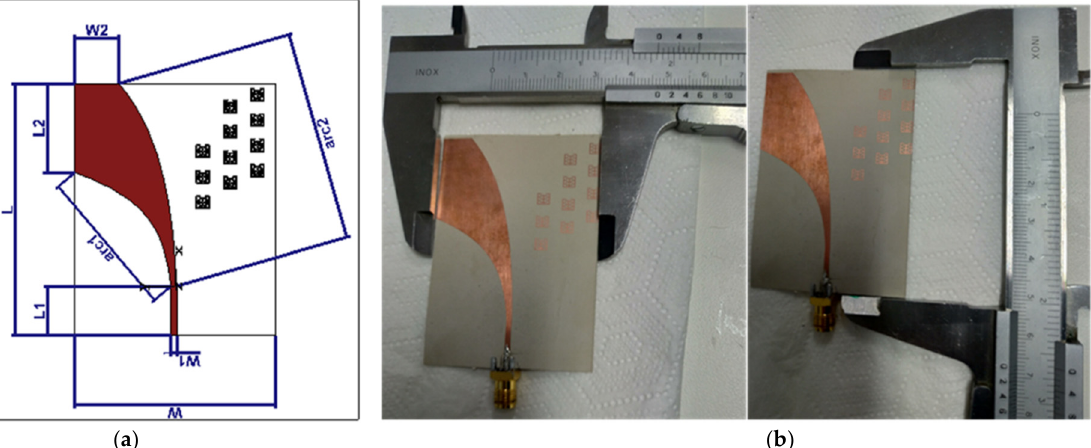
Figure 7. The unit cell results: ( a ) simulated S-parameters, ( b ) refractive index, ( c ) effective permit- tivity, and ( d ) effective permeability.